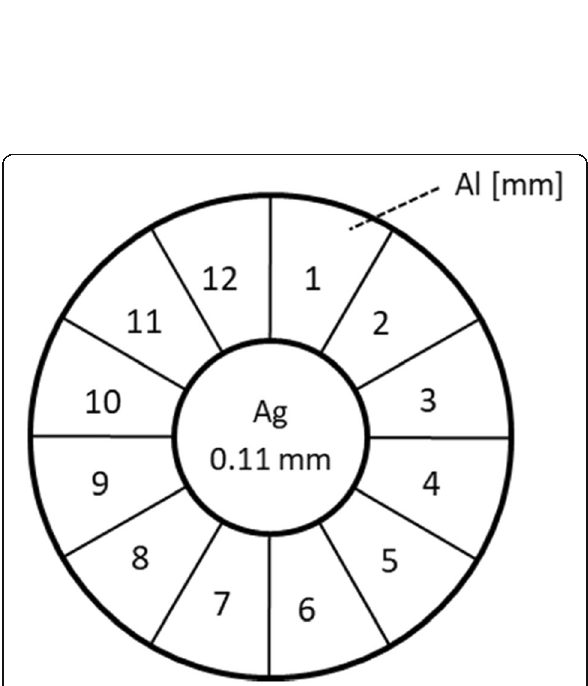
Fig. 2 Top view of Benoist hardness meter [16]. In the center a foil of silver (Ag, 0.11 mm thickness), surrounded by a circular staircase of aluminum (Al) with step thicknesses increasing clockwise from 1 to 12 mm. This penetrometer was held in the X-ray beam in front of a fluoroscopic screen and the Benoist hardness was the thickness of the Al-step that showed the same intensity as that of the Ag-foil in the middle. Evaluation was also done with a photographic plate